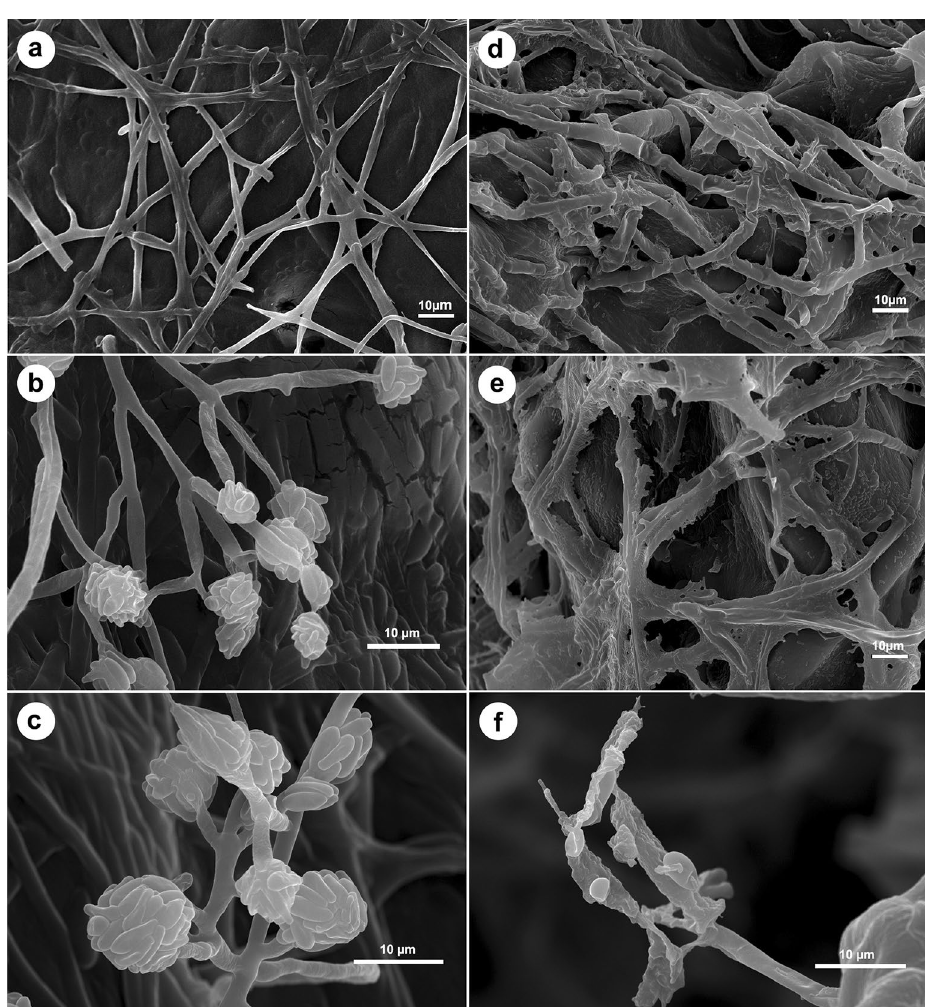
Figure 2. Scanning electron micrographs showing effects of lavender essential oil on morphology of Fusarium solani. The untreated fungus shows normal, intact, thick, and regular mycelia with smooth surface ( a ), typical, long, unbranched, and smooth-surfaced aerial conidiophores bearing false heads of ellipsoidal, non-septated microconidia ( b and c ). Mycelia of F. solani treated with lavender EO show severe collapse, distortion, shrinking, squashing, deformation, and rough surface with no observed conidia ( d – f